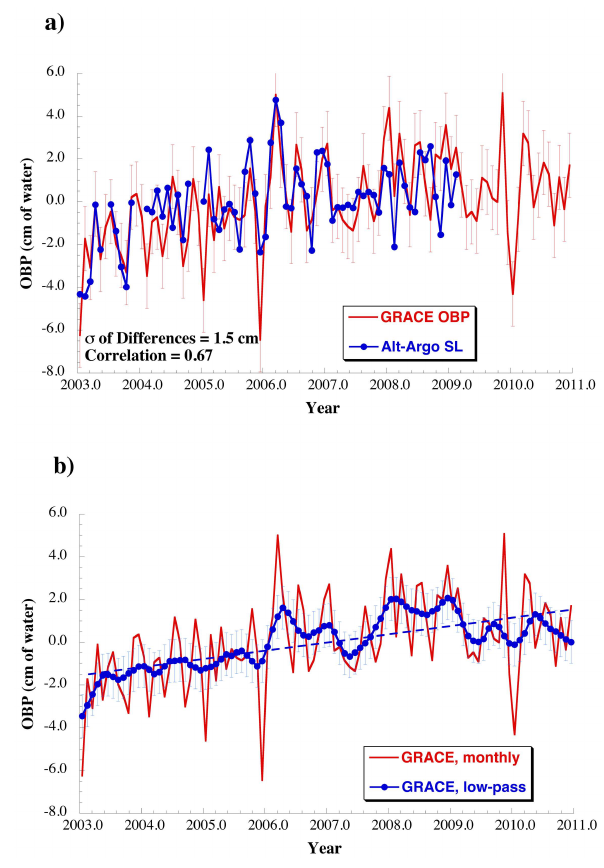
Fig. 6. Monthly, non-seasonal OBP averaged over the re- gion 35 ◦ N–45 ◦ N, 160 ◦ E–185 ◦ E for (a) GRACE and steric- corrected altimetry (updated from Chambers and Willis, 2008) and (b) GRACE but with an additional low-pass filter as described in text. The dashed line represents the best-fit linear